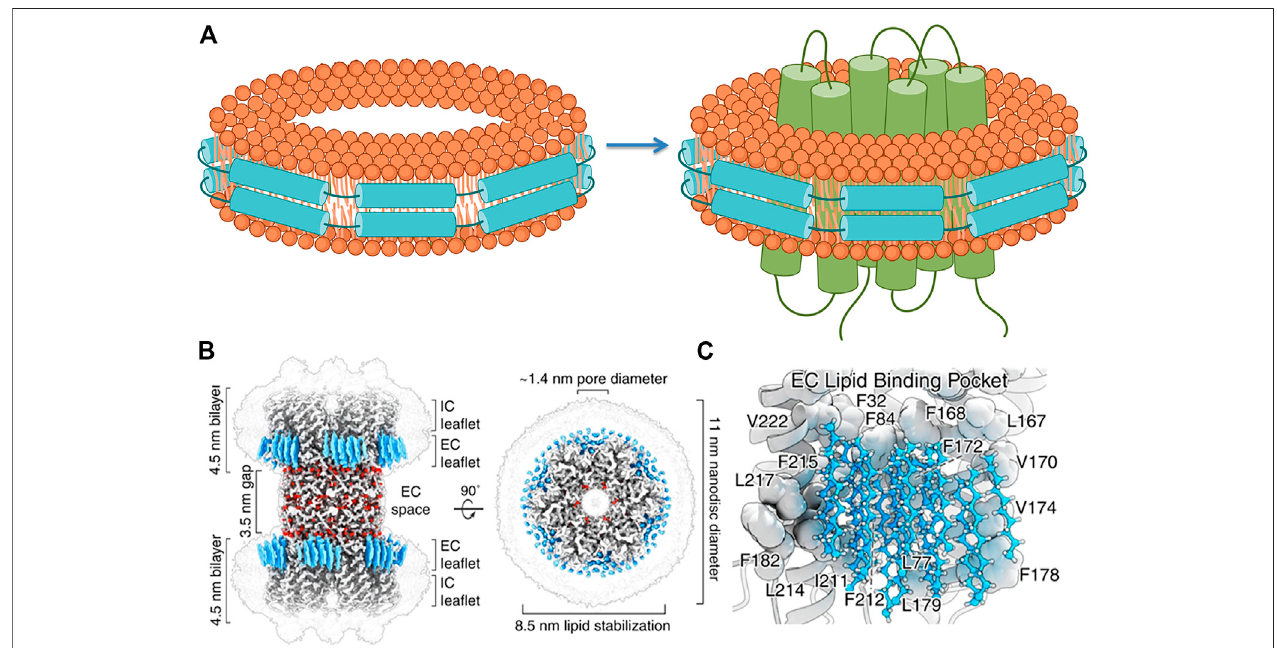
FIGURE 4 | Nanodisc system facilitates cryo-EM analyses of membrane proteins in native environment. (A) Reconstitution of a nanodisc-membrane protein complex: lipids enclosed by membrane scaffold proteins (MSP) to form a nanodisc are assembled with a membrane protein to form a nanodisc-membrane protein complex.(This fi gureismadebymodifyingnanodisccartoonsavailablefromBioRenderwithpermissionunderapurchasedlicense.) (B) Cryo-EMstructureofaconnexin proteininnanodisc. (C) Revelation oflipid-proteininteractions (BandC) areadopted from Figures1 , 3 inDenisov andSligar (2016)withpermissionfrom Creative Commons